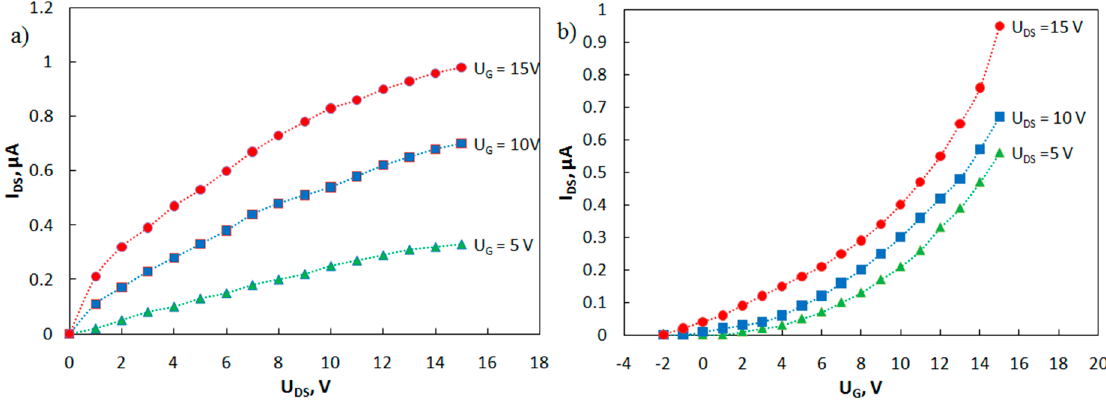
Figure 7. Family of ( a ) output and ( b ) transfer volt-ampere characteristics of the phototransistor.